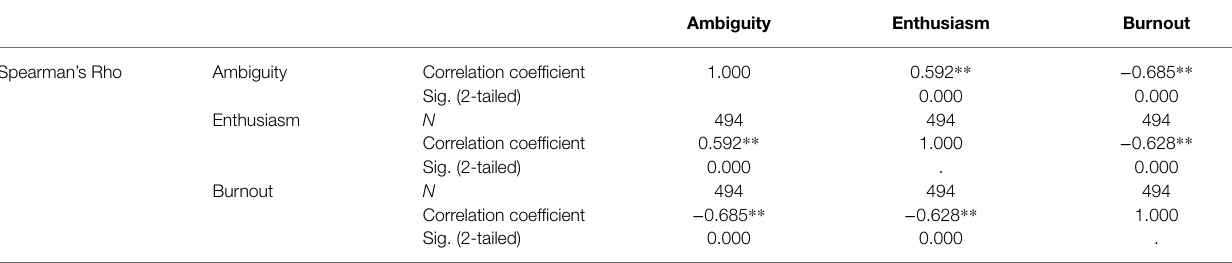
TABLE 3 | Correlations among teachers’ ambiguity tolerance, enthusiasm, and